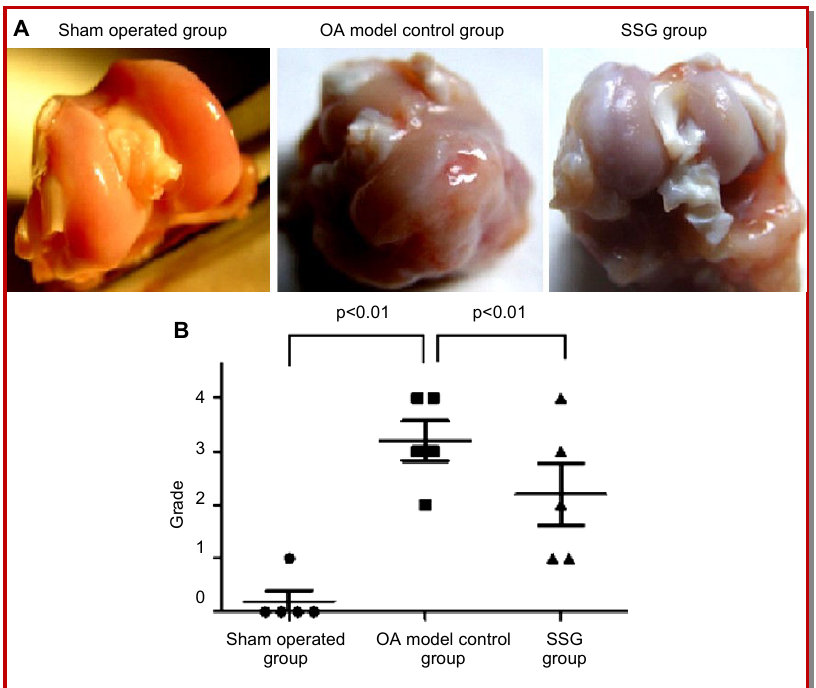
Figure 1. Gross pathological observation of the femoral condyle. A: Representative images of the femoral condyle from rabbits in sham operated, OA model control and SSG groups; B: Macroscopic grading scale of